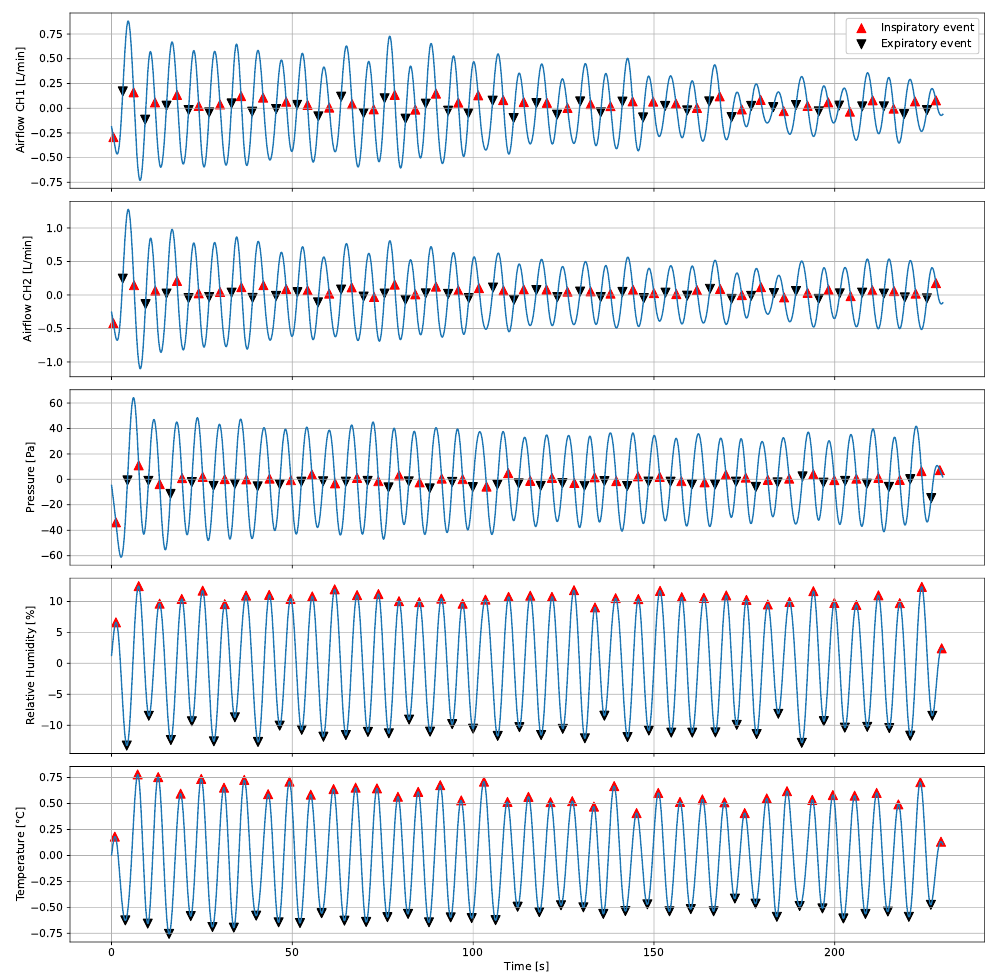
Figure 10. Inspiratory and expiratory events detection for one